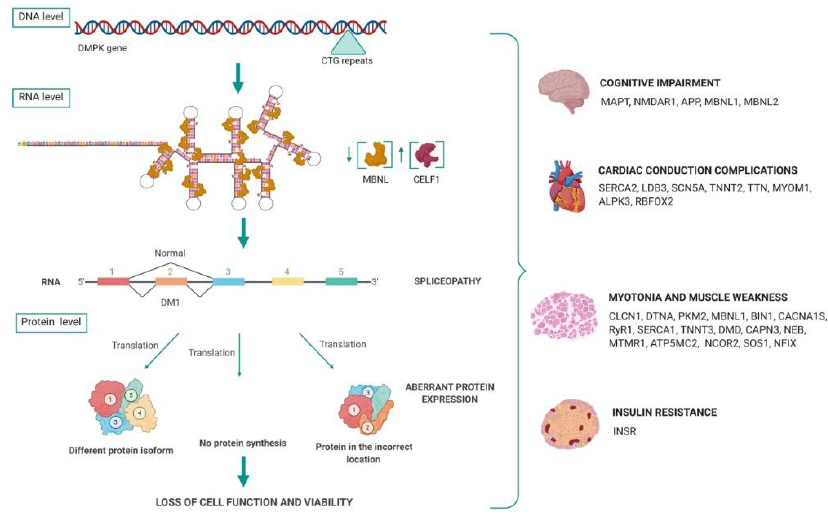
Figure 4. DM1 spliceopathy overview. At DNA level, CTG repeats code for hairpin CUG structures that bind MBNL1 proteins with high affinity. Due to MBNL1 loss, CELF1 is overexpressed through PKC phosphorylation and alters the splicing of different transcripts, mainly switching to embryonic isoforms. The splicing deregulation or spliceopathy induces an aberrant protein expression that provokes the loss of cell function and viability. Different transcripts from different tissues are incorrectly spliced, causing most DM1 symptoms. Created with Biorender.com.